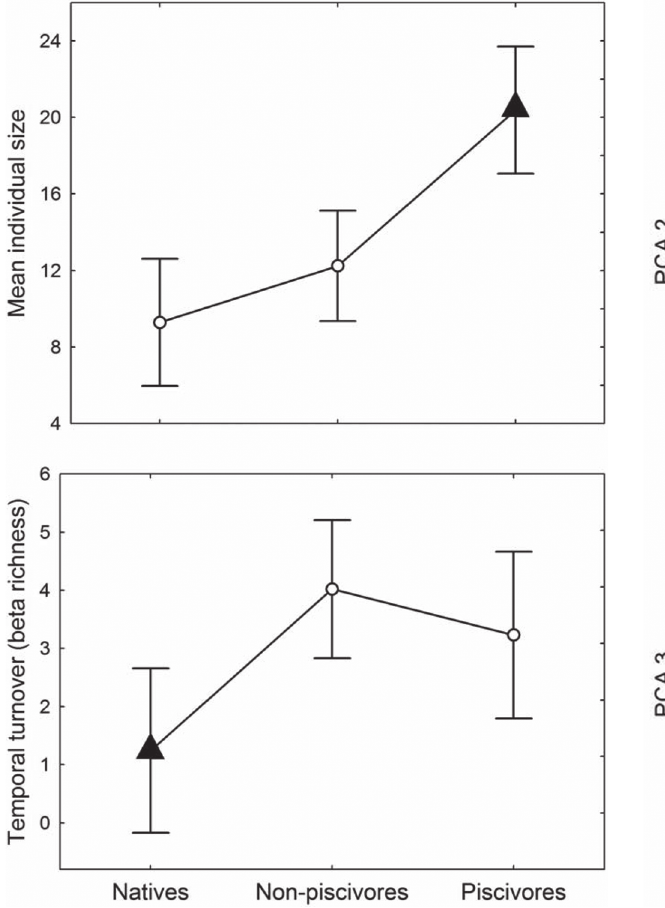
Fig. 5. Least-square means and 95% confidence intervals from ANCOVA of mean individual size and temporal turnover as related to the three lake categories. Different markers represent significantly different means as detected by planned contrasts with 5% significance level, first comparing lakes with any non-native species with those without them, and then comparing the two categories of lakes with non-natives (non-piscivores vs .